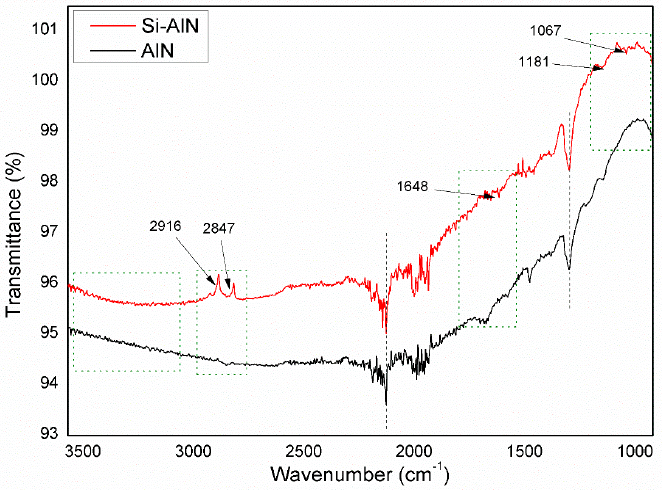
Figure 2. Fourier-transform infrared spectroscopy (FTIR) spectra of non-treated aluminum nitride (AlN) and Si–AlN. (AlN) and